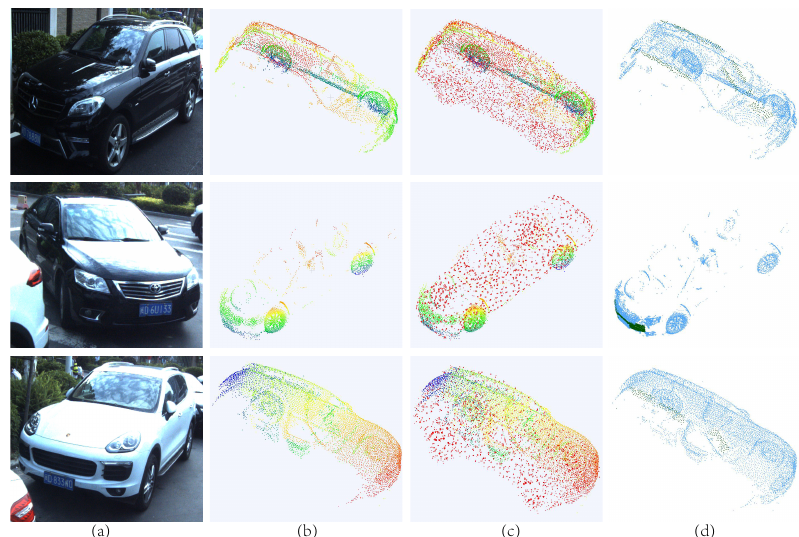
Figure 12. Results of the MLS objects completion. ( a ) Street images. ( b ) Original MLS point clouds (Missing more than a half). ( c ) The completion results of PCCNet . ( d ) The completion results of [8].